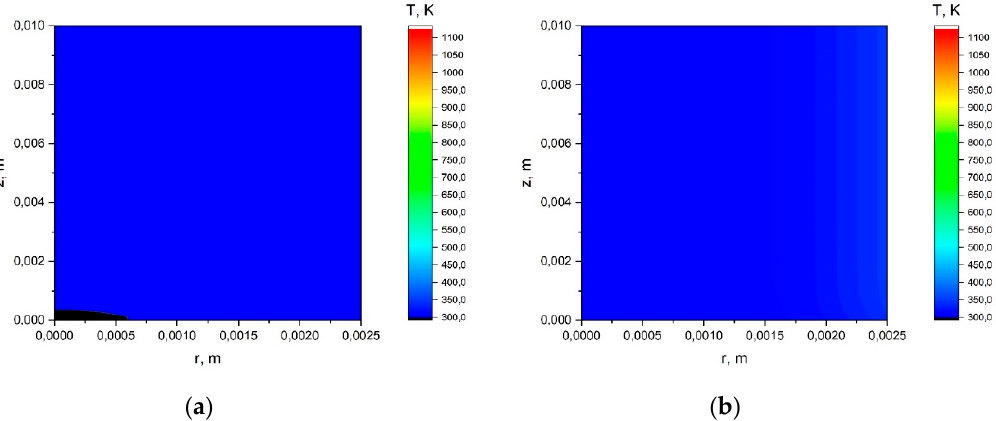
Figure A7. Temperature distribution in the stem of a herbaceous plant: R = 0.0025 m, t = 3 s, q = 0.5 kW/m 2 ( a ); R = 0.0025 m, t = 3 s, q = 3 kW/m 2 ( b ).